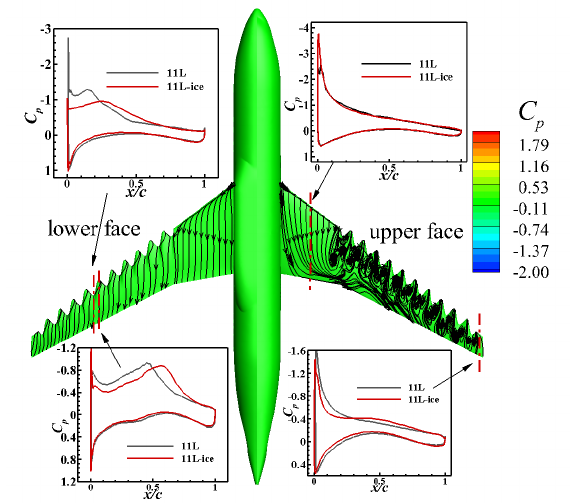
Figure 11. Flow field changes of 11L before and after ice accumulation.